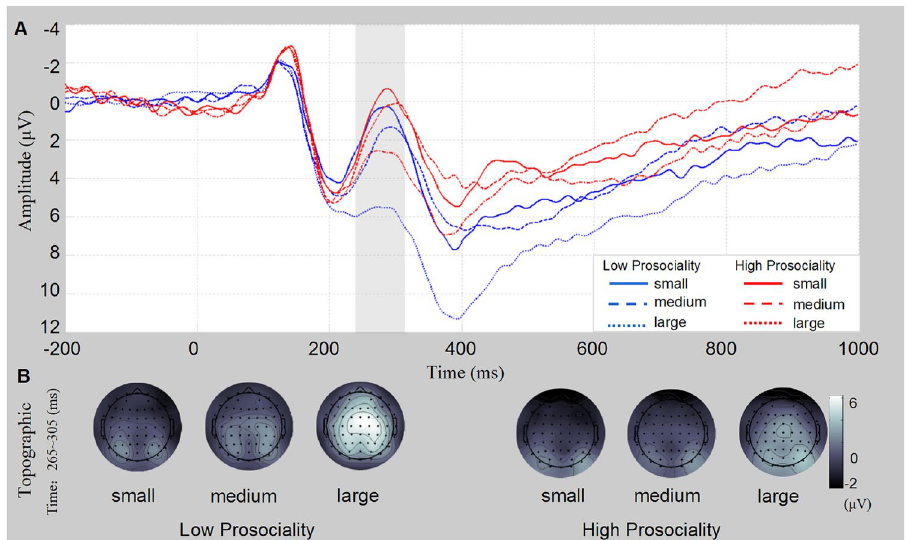
Figure 3. FRN results. ( A ) The mean waves of nine electrodes are shown. The gray area represents the selected time window. Small: the individual choose the card containing 0 star. Medium: the individual choose the card containing 1 star. Large: The individual choose the card containing 2 star. ( B ) The differential topographic map is